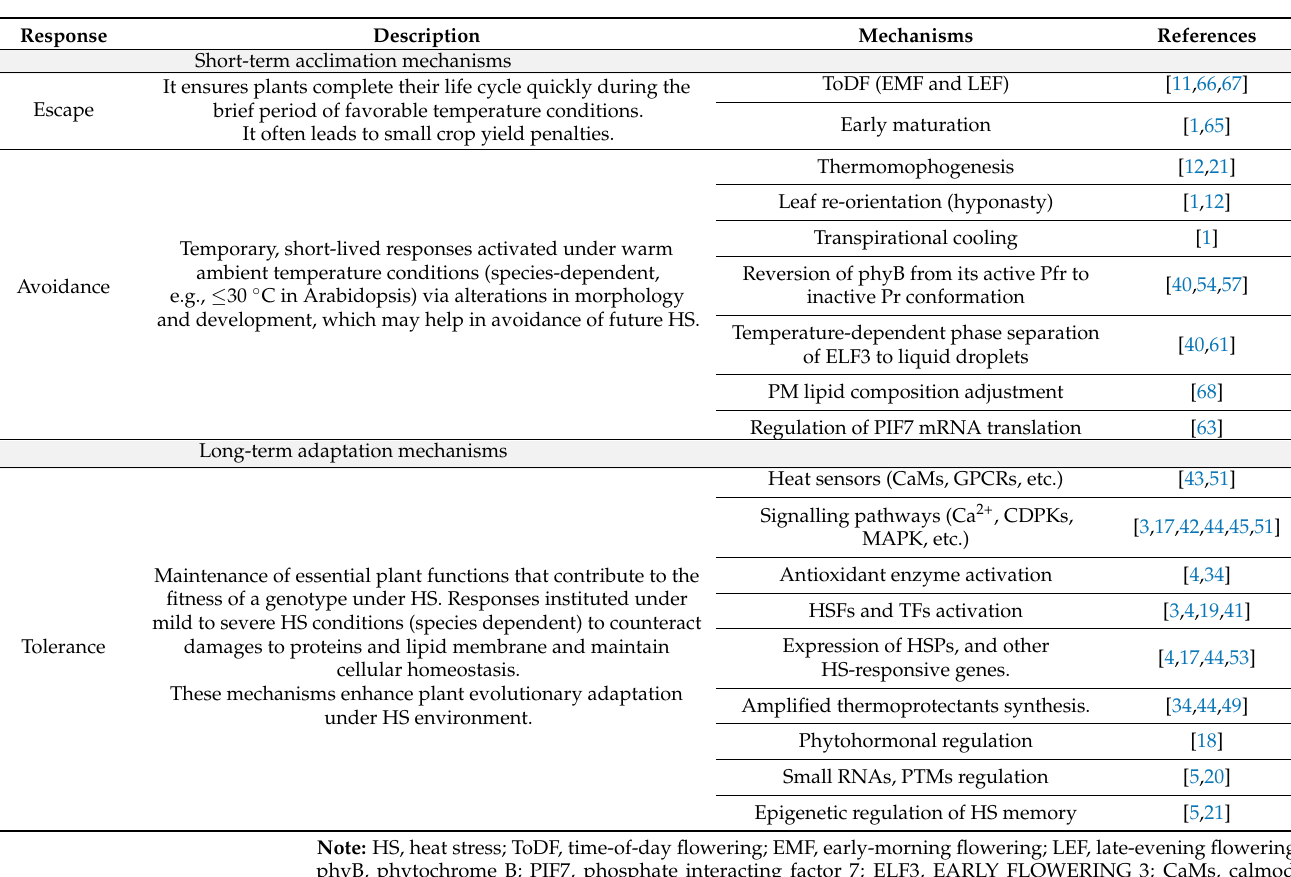
Table 1. Plant heat stress response